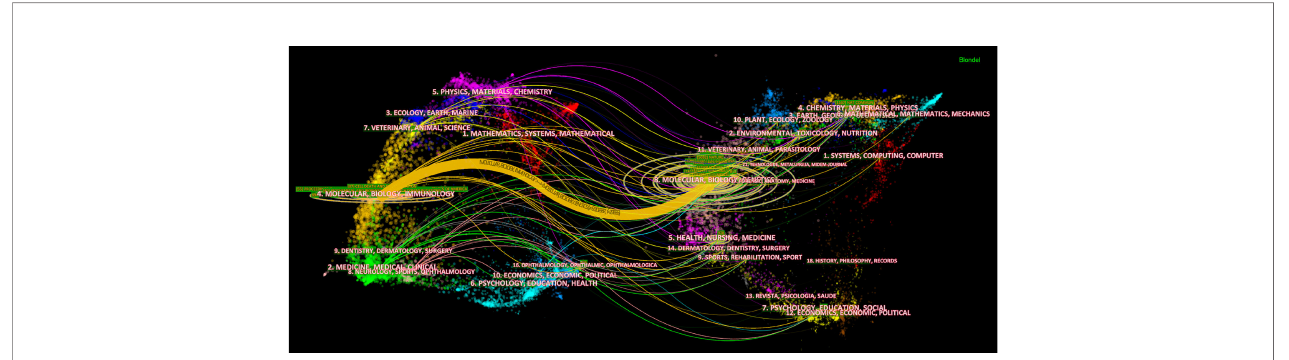
FIGURE 5 | The dual-map overlay of journals on necroptosis. The citing journals are on the left, the cited journals are on the right, and the colored path represents the citation